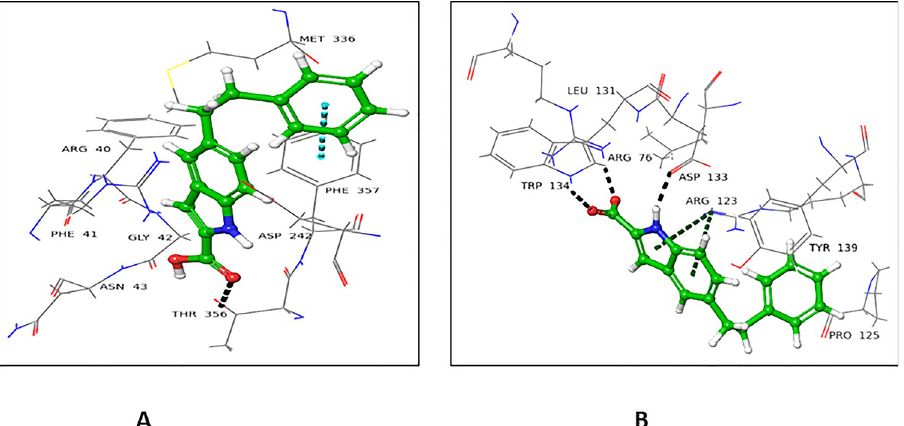
Fig 7. Interactions of compound 3 with ( A ) donor and ( B ) acceptor site. 3D Ligand interactions diagram; black dashed lines indicate hydrogen bonds; green dashed lines indicate π -cation interactions, while blue show π - π stacking